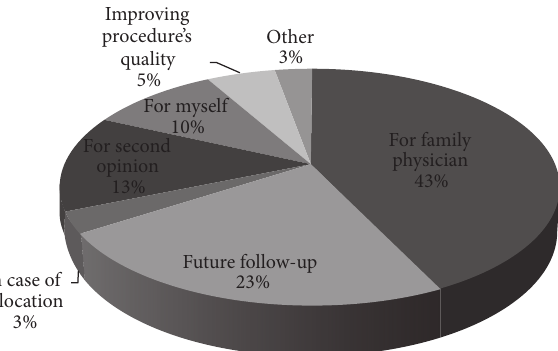
Figure 1: Patients’ reasoning for interest in a digital documentation of the